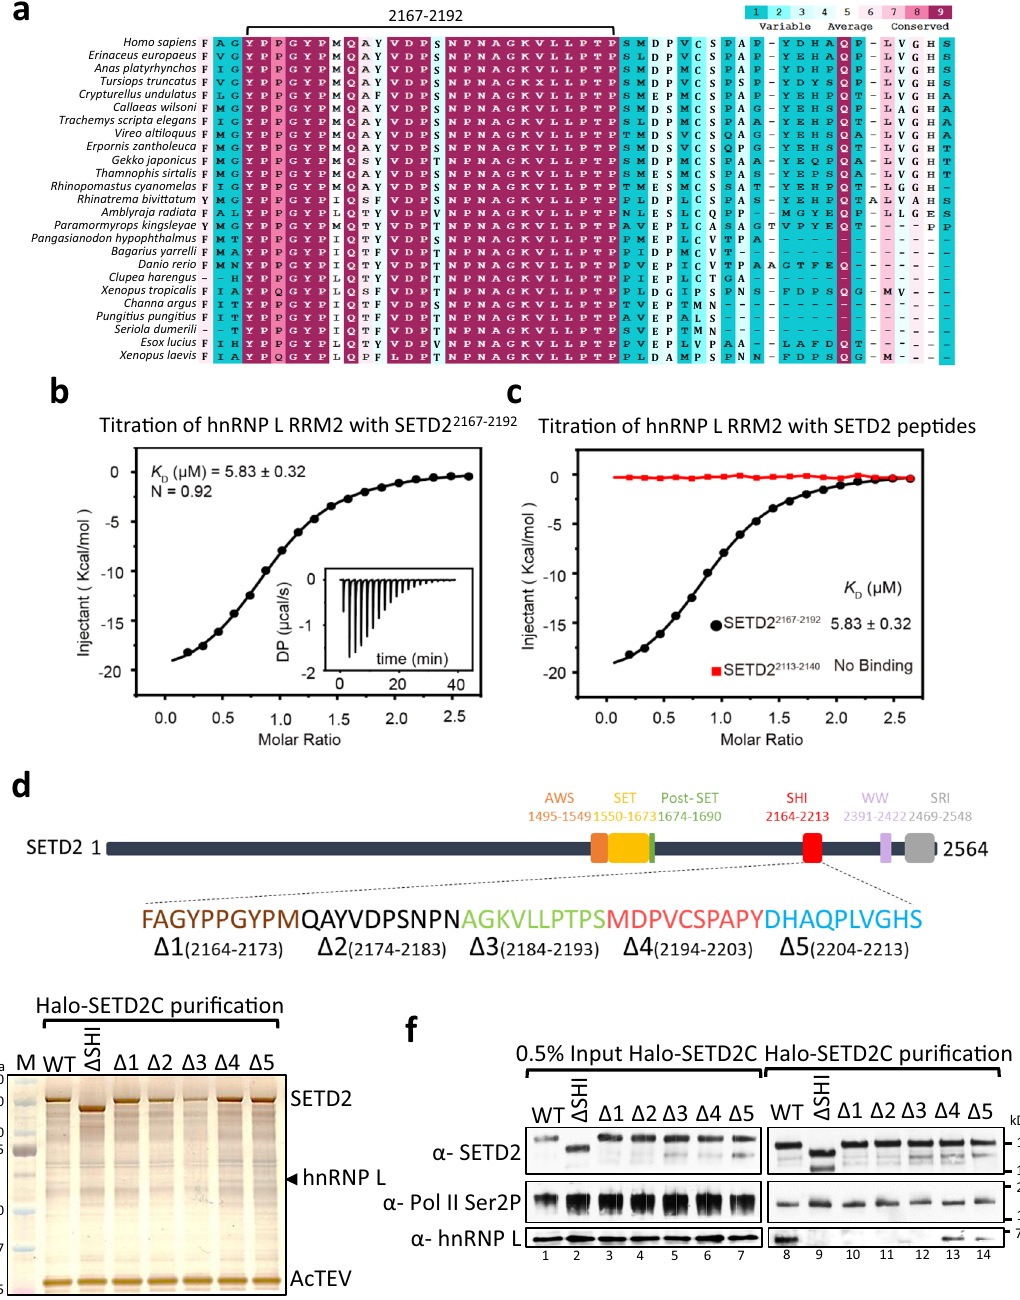
Fig. 1 A conserved stretch in SETD2 is responsible for its interaction with hnRNP L. a Multiple sequence alignment of previously identi fi ed SHI domain in SETD2. b Exemplary ITC titration data of hnRNP L RRM2 with SETD2 2167 – 2192 and its fi tting curve are shown. K D dissociation constant, DP differential power, N binding stoichiometry. For the arithmetic mean of K D values of the three independent experiments and the thermodynamic parameters see Supplementary Table 1. All ITC binding curves are shown in Supplementary Table 2. c ITC fi tting curves of hnRNP L RRM2 with SETD2 2167 – 2192 (black) and SETD2 2113 – 2140 (red) are shown. d Illustration showing the deletions in SETD2 SHI domain that were made to perform af fi nity puri fi cation. e Silver staining and f western blotting of af fi nity-puri fi ed complexes of SETD2C and its mutants. The experiment was repeated three times all yielding similar results. Source data are provided as a Source Data fi